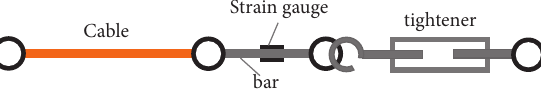
Figure 7: Details of steel cable